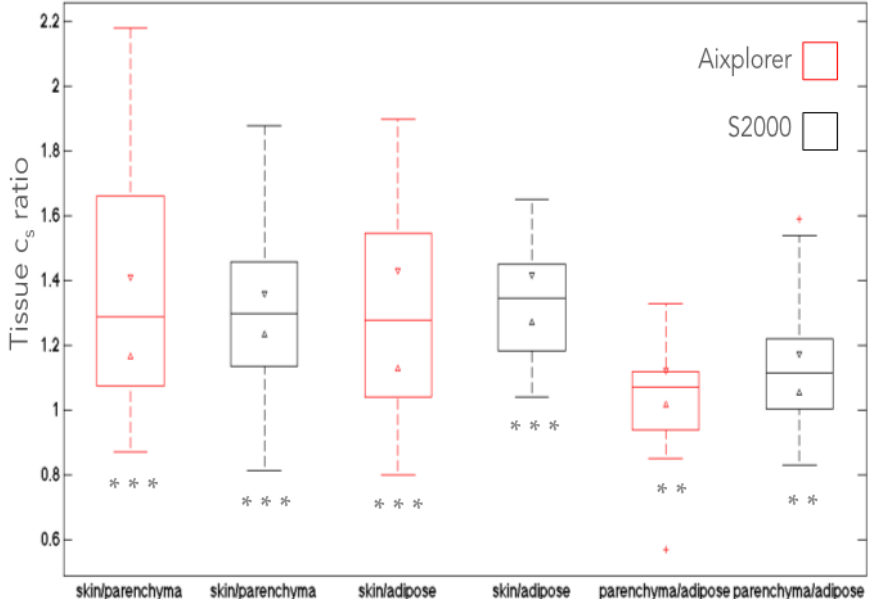
Figure 5. Tissue c s ratios measured in skin, adipose and parenchyma in individual elastograms of the breast using Aixplorer and S2000. (See Figure 2 caption for full explanation of box plot). Aixplorer data were acquired using ROIs that did not include artefacts. The IQR and range may be influenced by variation between volunteers, breast quadrants and transducer orientation. ** or *** indicates where median c s estimates for different tissue types were significantly different with p -value < 0.01 or < 0.001, respectively.